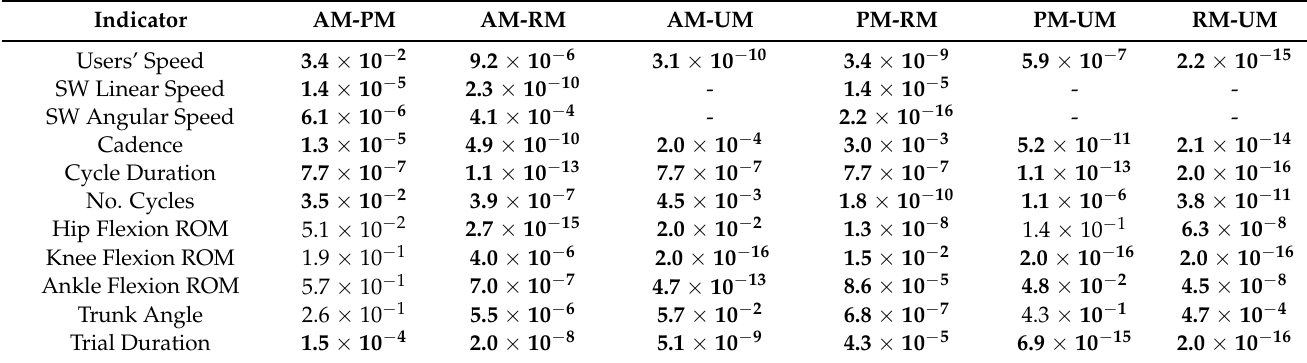
Table 6. Obtained p -values after pairwise comparisons of kinematic and additional parameters using post-hoc tests.